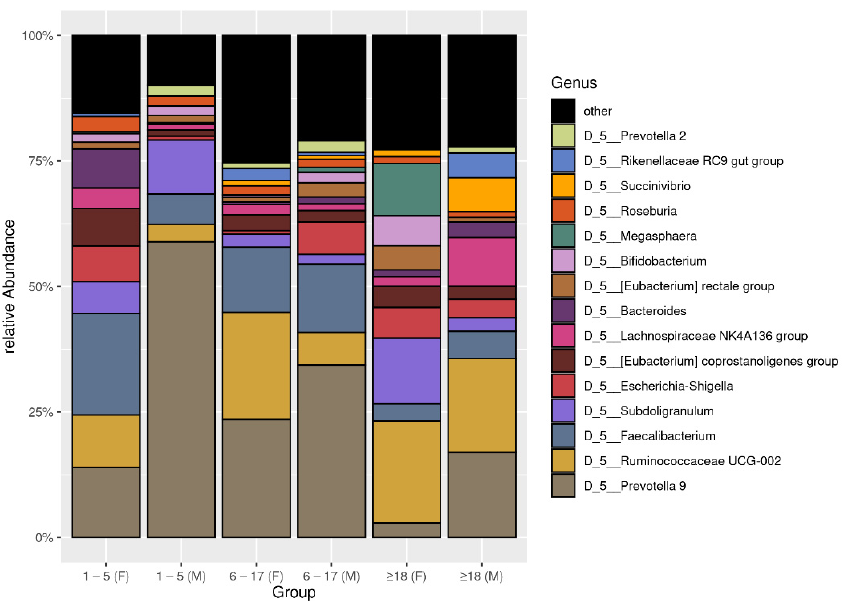
Figure 2. The plot of top 15 relative bacterial abundances at genus level. The subjects were distinguished by sex and age.